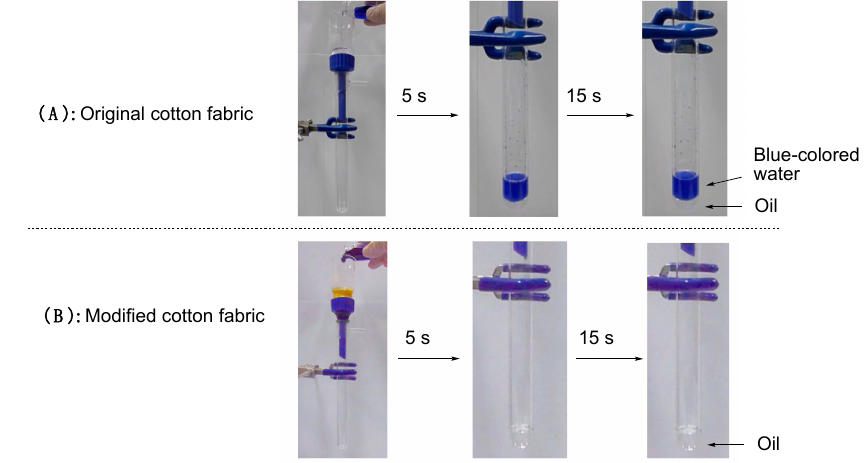
Figure 7. Separation of blue-colored water that was colored with CuSO 4 ·5H 2 O and 1,2-dichloroethane using pristine cotton fabric ( A ) and the modified cotton fabric with R F -VMSiO 2 /TAZ composites (Run 1 in Table 2) ( B ).